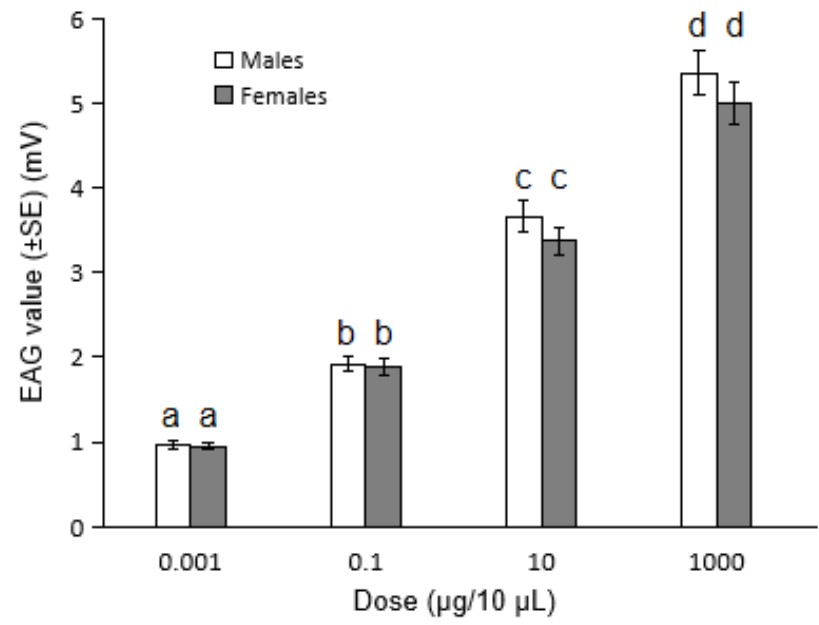
Figure 4. EAG responses of male and female S. granarius to 3-hydroxy-2-butanone at different concentrations ( n = 9). Different letters (a, b, c and d) above bars indicate significant difference in EAG value at different concentrations ( p < 0.05, one-way analysis of variance, Duncan’s